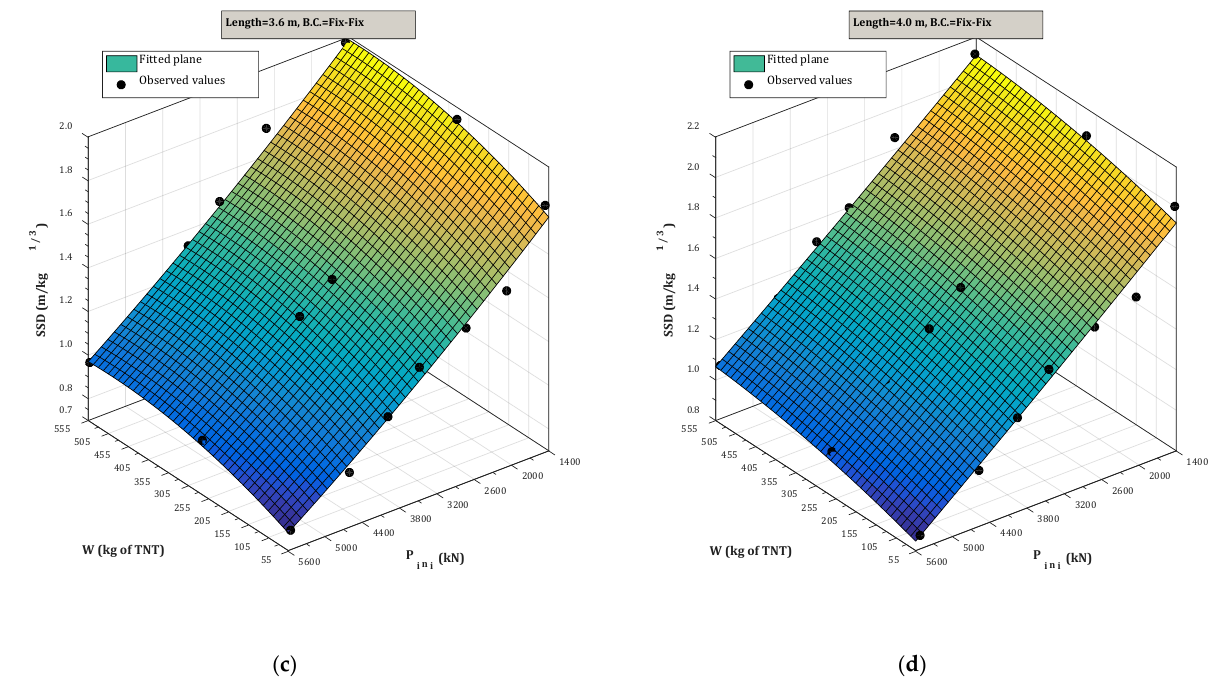
Figure 10. SSD values for steel columns with fixed ends and different lengths: (a) L = 2.8 m, (b) L = 3.2 m, (c) L = 3.6 m and (d) L = 4.0 m